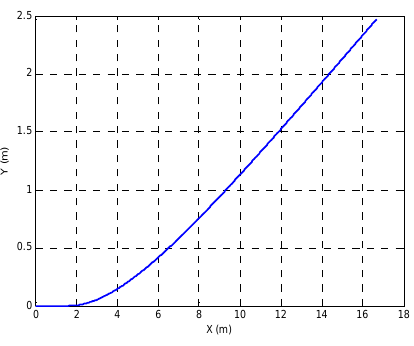
Fig.5. Disturbed route of